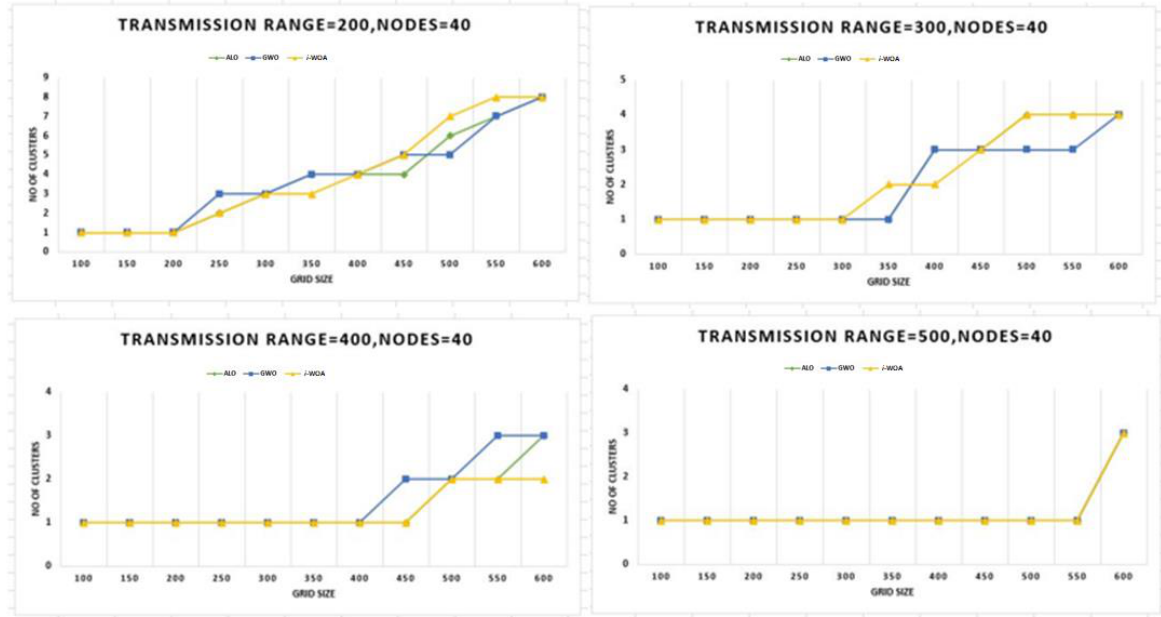
Figure 6. Comparison of 40 Nodes on a Grid with Different Numbers of Clusters .